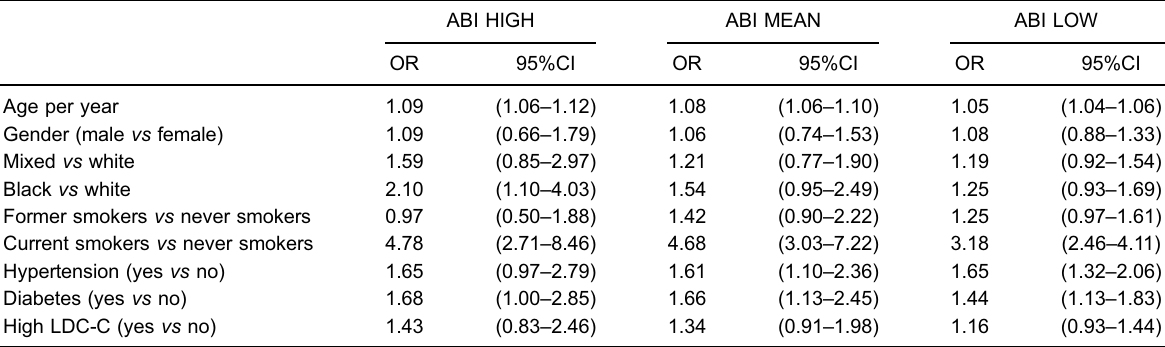
Table 3. Odds ratio (OR) and 95% con fi dence interval (95%CI) for the association between each category of ankle-brachial index (ABI) and cardiovascular risk factors at the baseline of the ELSA-Brasil Study. ABI